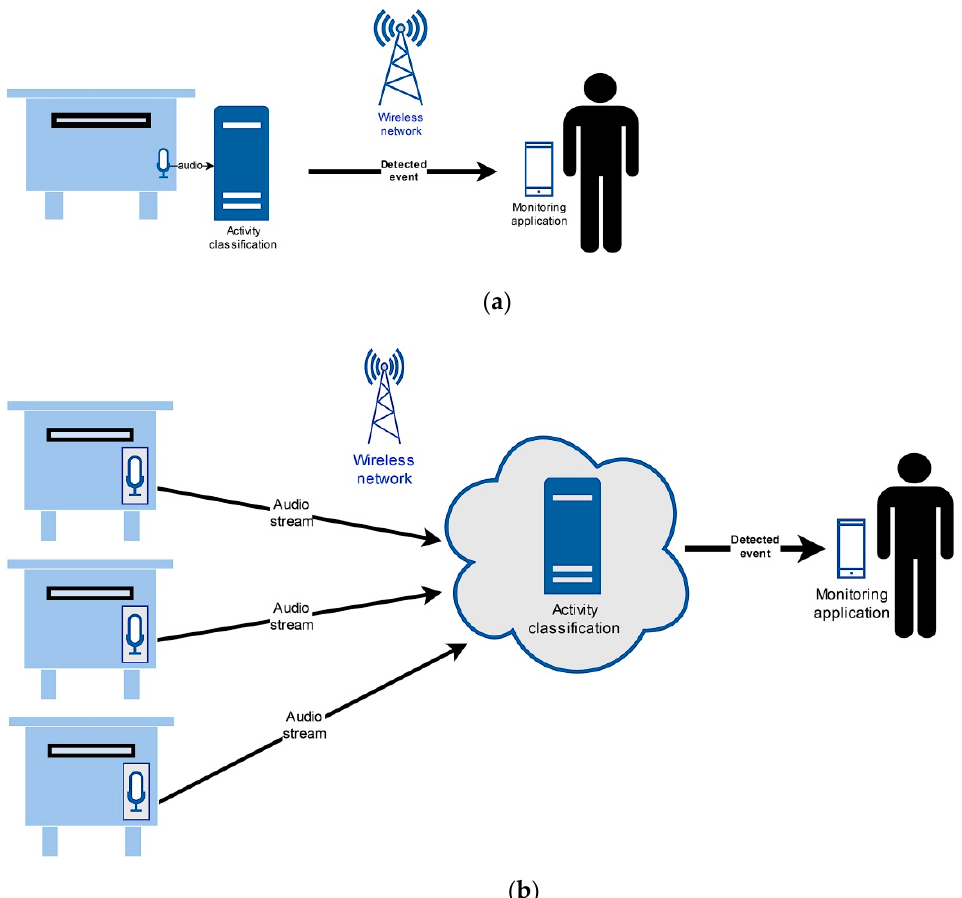
Figure 1. IoT architecture design with a server at the beehive location ( a ) or at a central location ( b ).